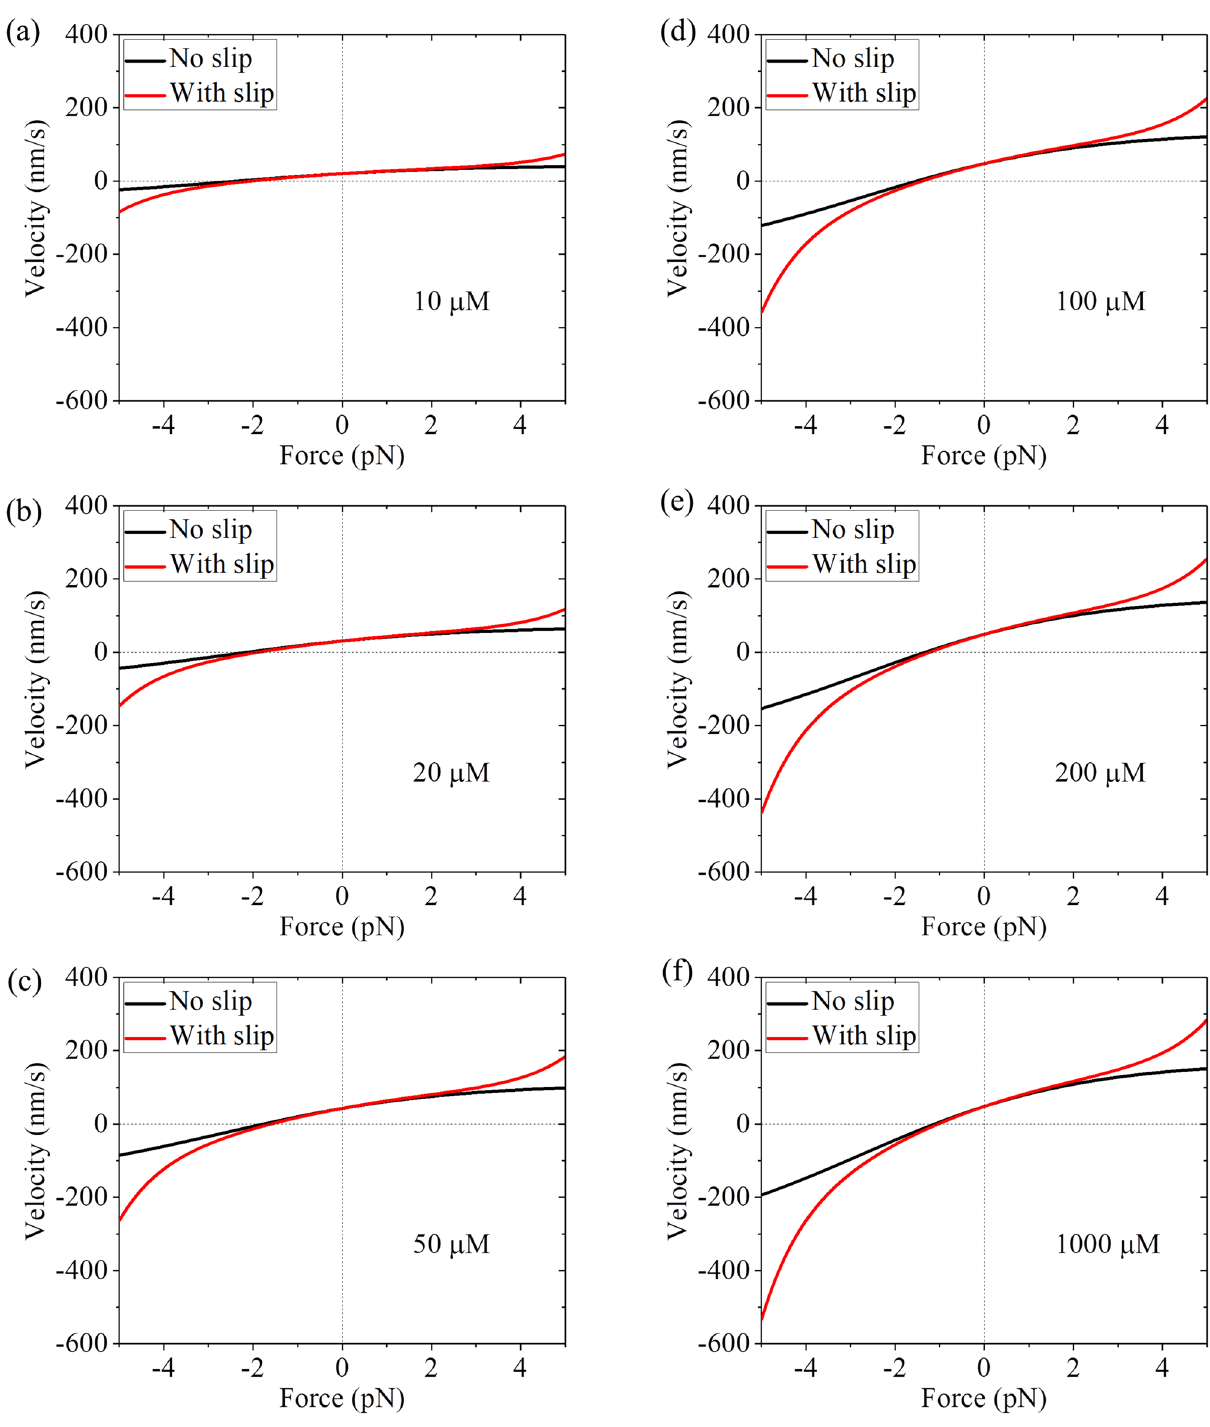
Figure 3. Results for velocity of kinesin-8 Kip3 motor versus load at non-saturating ATP. ( a ) 10 µ M ATP. ( b ) 20 µ M ATP. ( c ) 50 µ M ATP. ( d ) 100 µ M ATP. ( e ) 200 µ M ATP. ( f ) 1000 µ M ATP. Note that the six graphs have the same coordinate